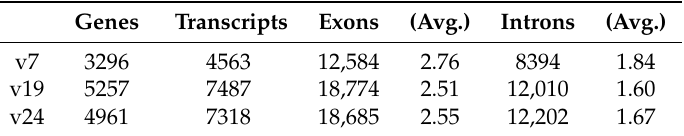
Table 2. Overlap between lincRNAs expressed in the lymphoma dataset and different versions of the GENCODE